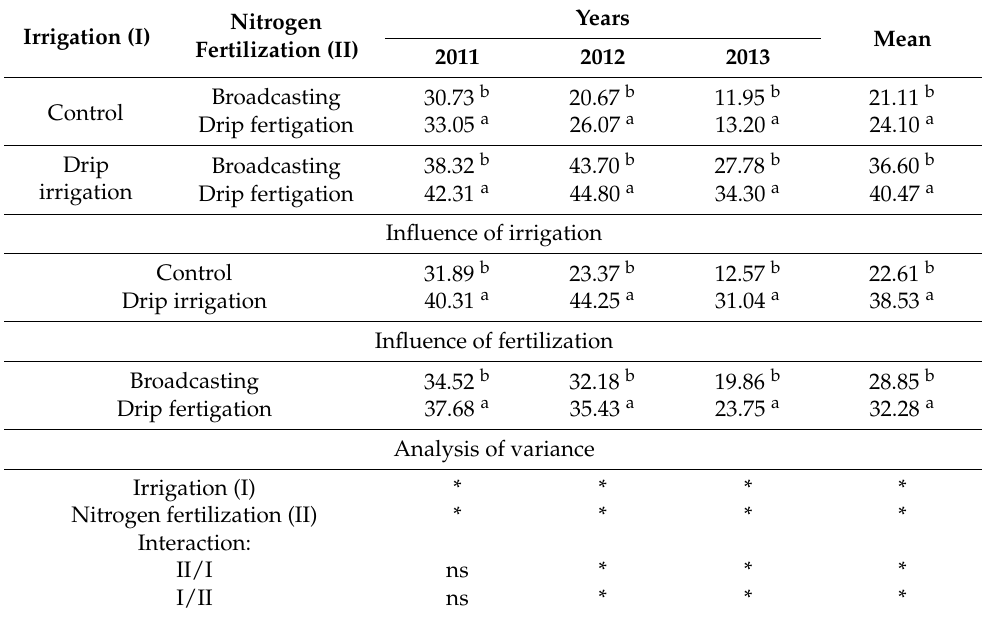
Table 6. Marketable tuber yield (t ha − 1 ) of potato cultivar Courage in